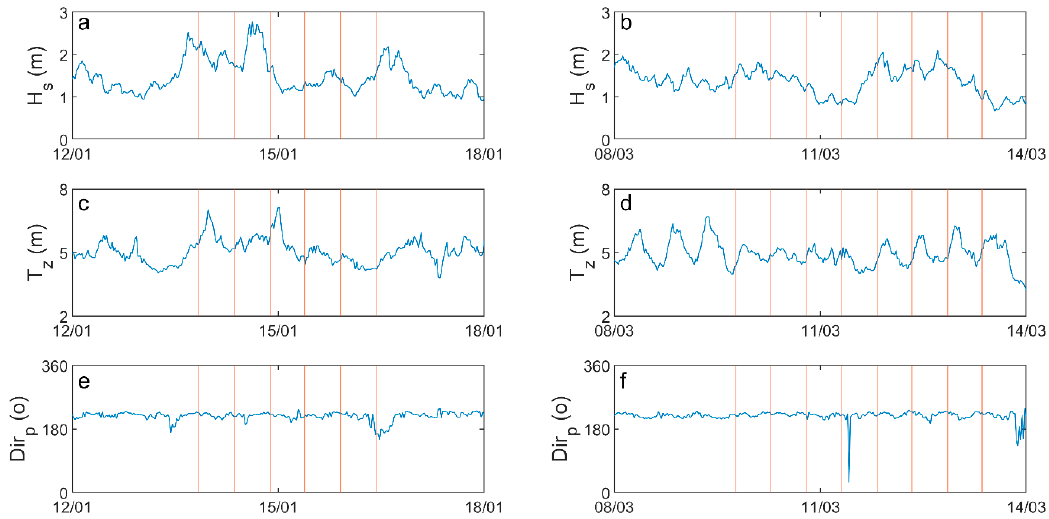
Figure 5. Wave parameters (significant wave height (H s ), mean wave period (T z ), peak direction (Dir p ) measured at the Swansea Bay waverider during the course of the two deployments: ( a , c , e ) deployment 1; ( b , d , f ) deployment 2. Blue lines indicate the wave parameters and orange lines the times of high tide.